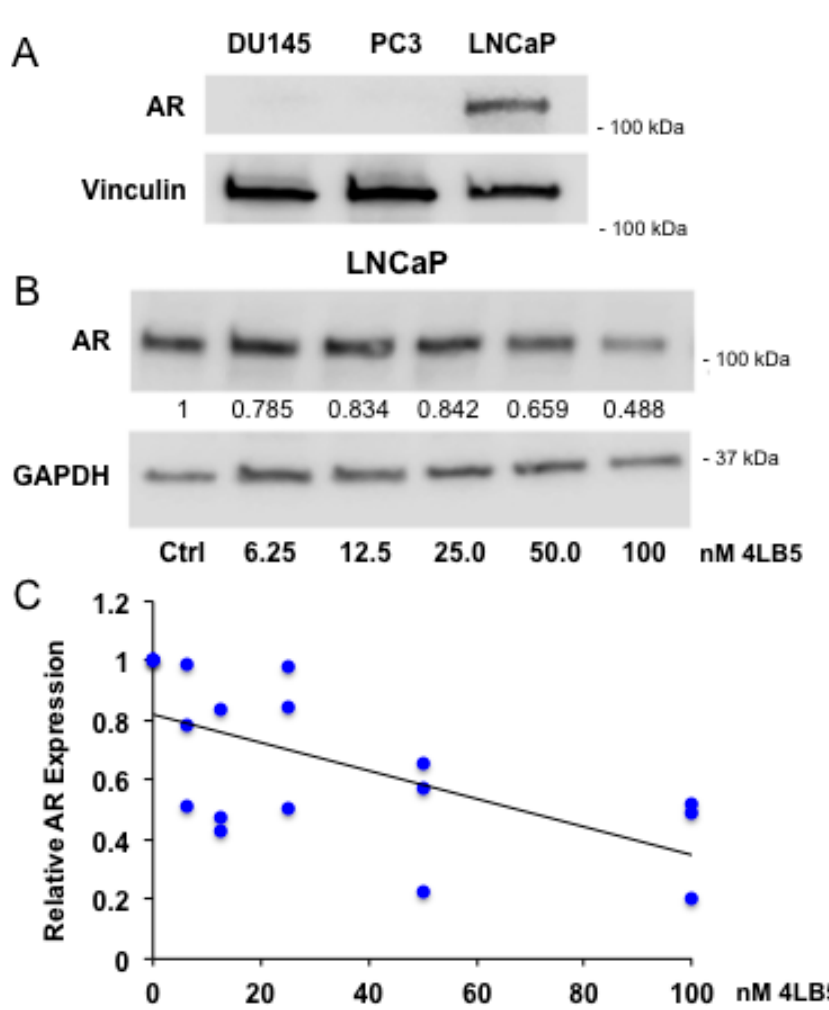
Figure 5. 4LB5 Reduces AR Expression in Hormone-Sensitive LNCaP Cells ( A ) Basal androgen receptor (AR) expression in PCa cell lines. ( B ) LNCaP cells were treated with the indicated increasing concentration of 4LB5 for 48h and AR expression was assessed by Western blot. Additional loading control using Ponceau S staining is included in Figure S3A. ( C ) Levels of AR were normalized to GAPDH (Glyceraldehyde 3-phosphate dehydrogenase), plotted, and subjected to linear correlation testing (Pearson (displayed): r = − 0.621, p = 0.006, Spearman: rs = − 0.650, p = 0.003). Plotted data are